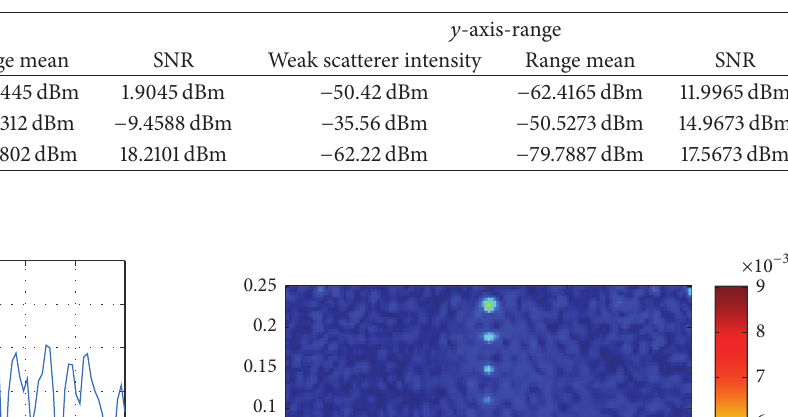
Table 1: SNR analysis for irregular geometry.